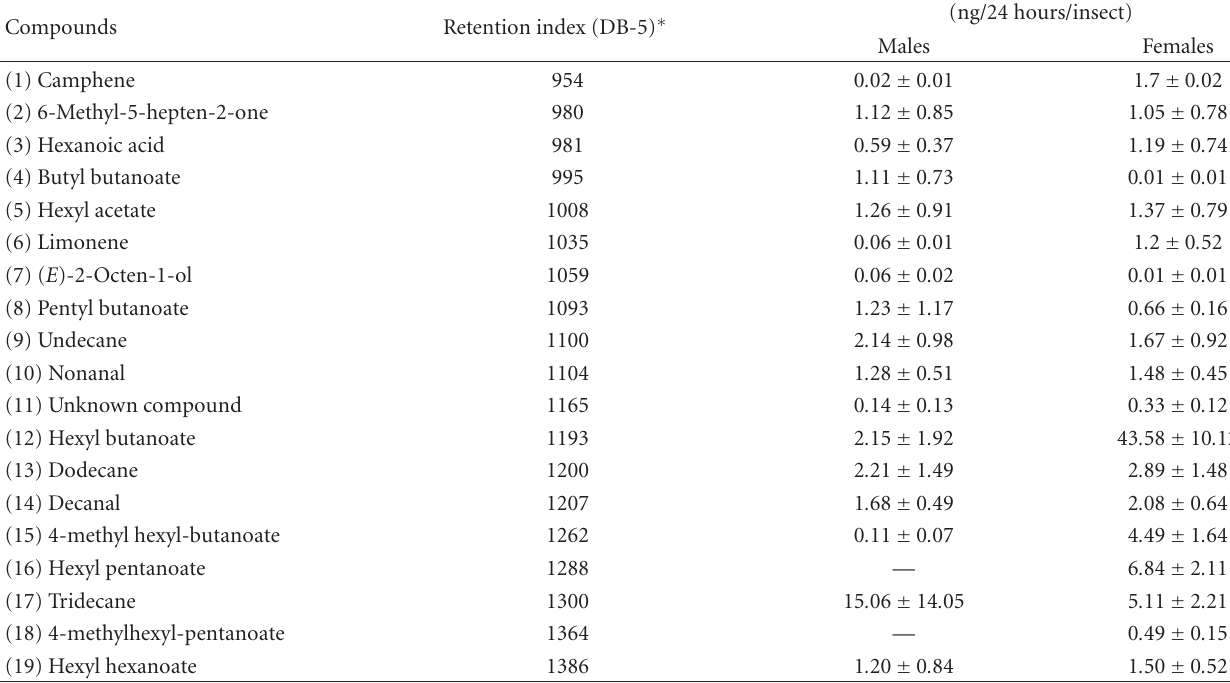
Table 1: Amounts of the compounds identified in extracts obtained from air-entrainment of males and females of N. parvus ( N = 5). Compounds